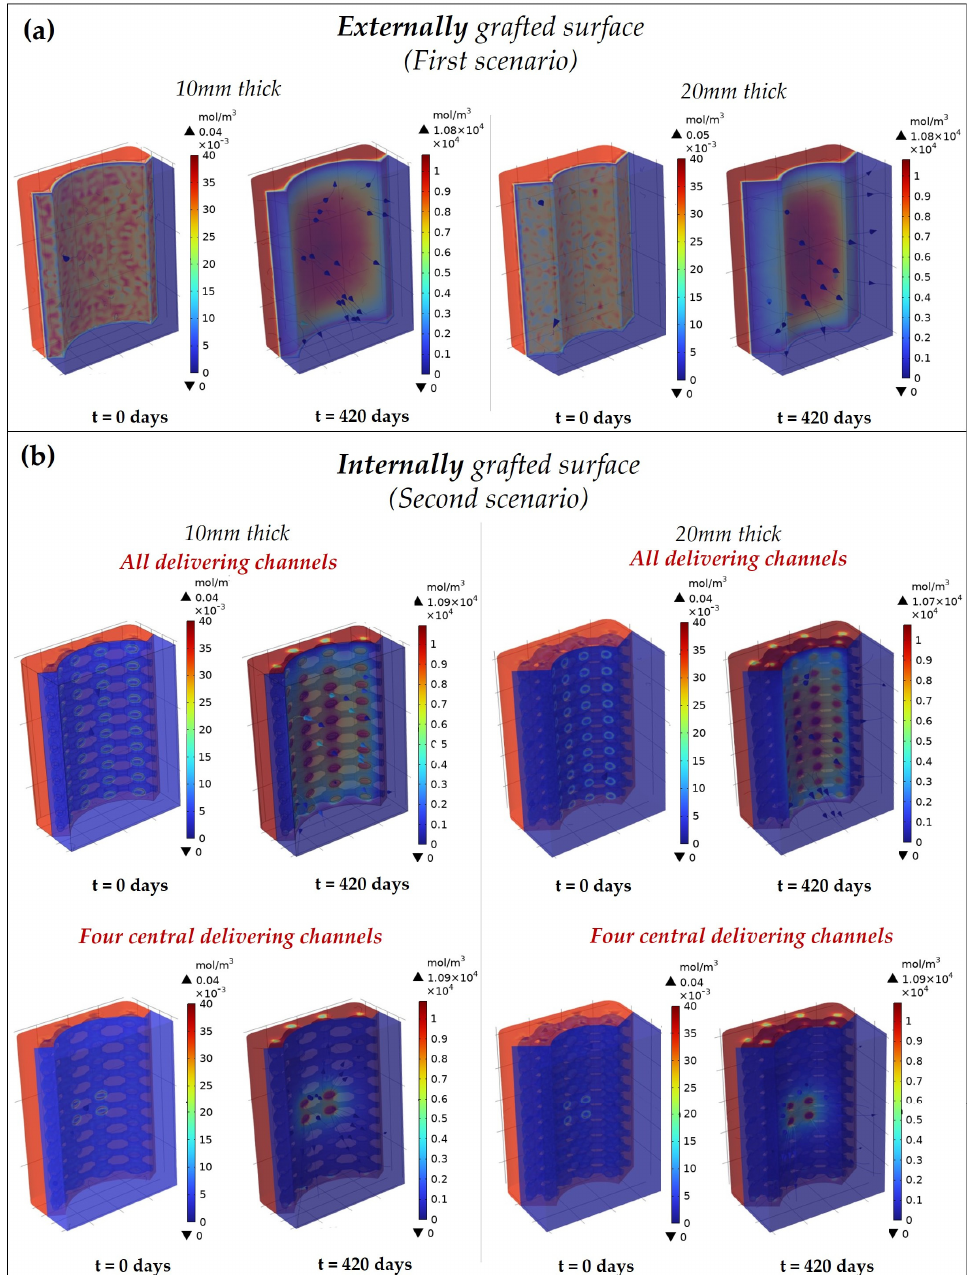
Figure 3. Degradation behavior of the 3D complex scaffold in the two scenarios: ( a ) externally (first scenario) and ( b ) internally (second scenario) grafted with ICOS-Fc. The second scenario is shown both with all and only four central delivery channels open. The spatial distribution of the grafted protein in the different domains (represented by the monomer concentration) is reported at 2 different time points: t = 0 days, at the beginning the hydrolysis is not yet started and the protein is completely grafted on the scaffold; at t = 420 days (end time point) the products diffuse towards the periosteum from the external or internal grafted surface. The flow direction of the degradation products is highlighted by the streamlines.